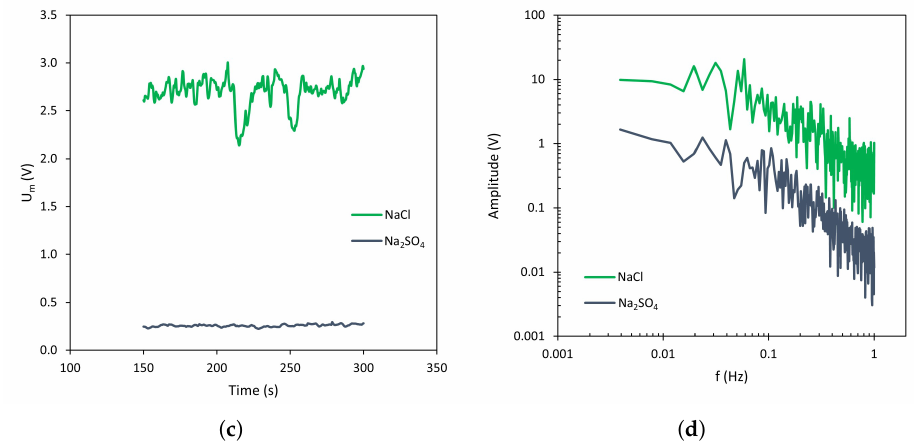
Figure 10. ( a ) Chronopotentiometric response obtained with AMV-N membrane at 1.5 × i lim at 400 rpm, ( b ) Fourier Transform, ( c ) Chronopotentiometric response obtained with HC-A membrane at 1.5 × i lim at 400 rpm, ( d ) Fourier